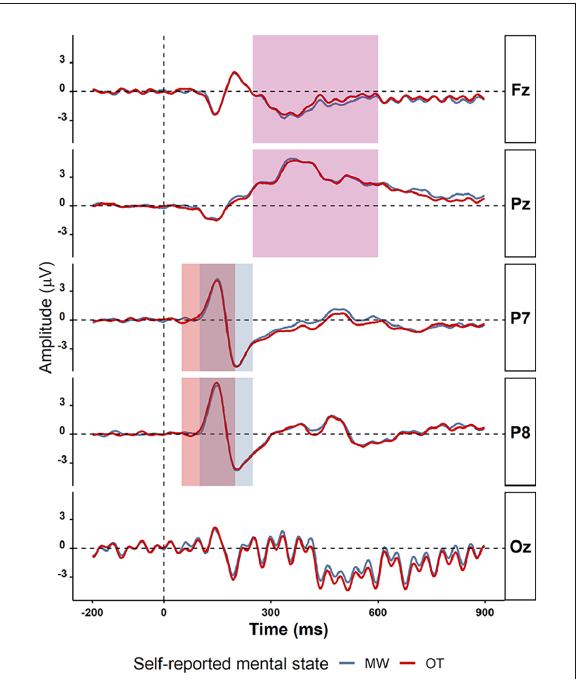
FIGURE8 The grand average ERPs on electrodes P7, P8, Fz, Pz, and Oz for mind-wanderingtrials(MW;blue)andon-tasktrials(OT;red).The time windows used for detecting the peaks of the various ERP components are shown in different rectangles: P1 (50–200 ms in light green), N1 (100–250 ms in light purple), and P3 (250 − 600 ms in light yellow). The electrodes and time windows were selected on the basis of previous studies on